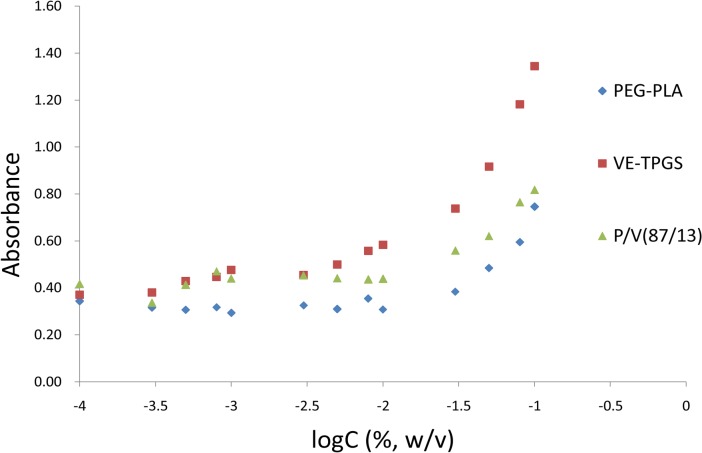
UV intensity plot of I2 versus logarithm of the polymer mass concentration (n = 3).